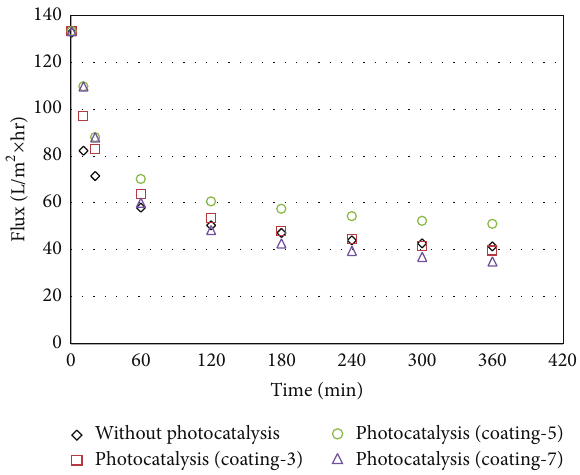
Figure8:PermeatefluxofUFforfeedwaterpretreatedbyTiO 2 -film photocatalysis (10KDa).